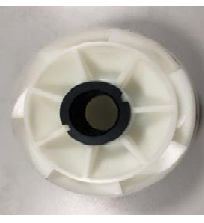
Figure 5. Impeller and diffuser. ( a ) Impeller, ( b ) diffuser.